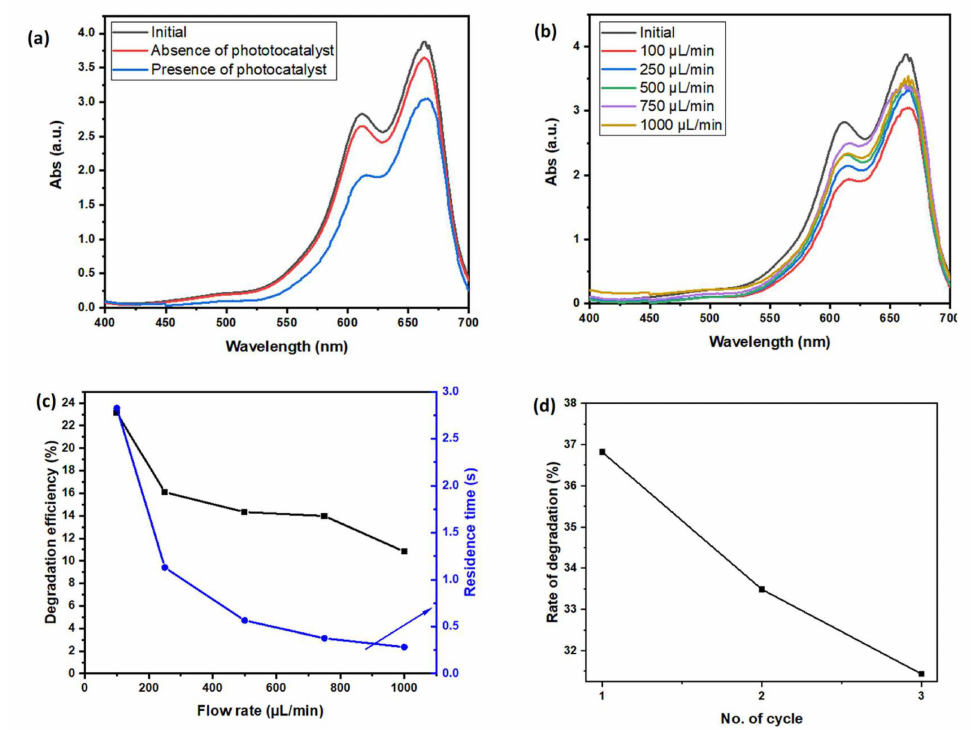
Figure 5. UV absorption spectroscopy of MB solution before and after one-pass photocatalytic degradation within the microreactor at a flow rate of 100 µ L/min ( a ), spectral changes during degradation of MB before and after a one-pass photocatalytic degradation within the microreactor containing ZnO NRs/rGO at varying initial flow rates ( b ), the degradation rate of MB solution before and after a one-pass photocatalytic degradation within the microreactor containing ZnO NRs/rGO at varying initial flow rates ( c ), and repeatability test results ( d ).